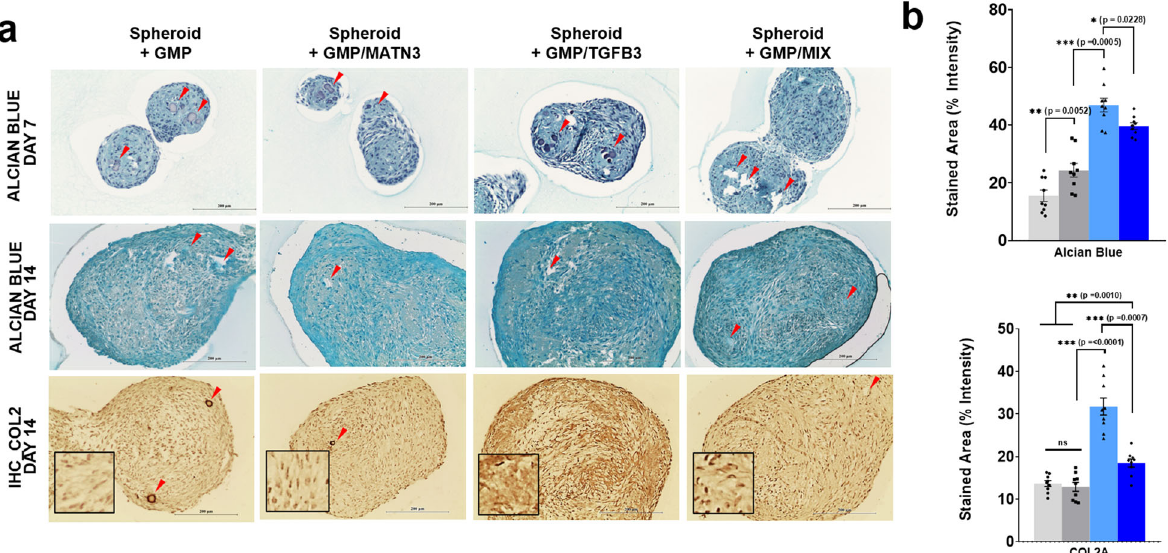
Fig. 6 Alcian blue staining and immunohistochemical analysis of collagen 2 A in composite spheroids (Day 7 and 14). Representative bright- fi eld images of Alcian blue staining seven days post differentiation ( a , topmost row), 14 days post differentiation ( a , middle row), and immunohistochemical labeling of collagen 2A on 5-µm sections of composite spheroids ( a , bottom row). Scale bars = 200 µm. Color and staining intensities of each section were digitally quanti fi ed using ImageJ software ( b ). The images are representative images of 9 sections from three independent spheroids. Red arrows indicate the location of gelatin microparticles in the differentiating ASC